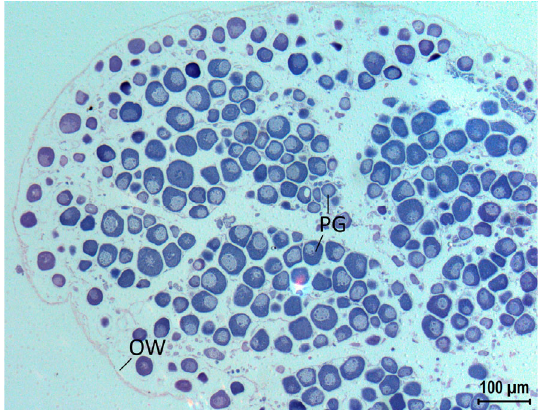
Figure 3. Histological slide of the ovary of Magnisudis atlantica MHN USC 25209, 402 mm TL (magnification 10×); PG = primary growth oocyte; OW = ovarian wall.